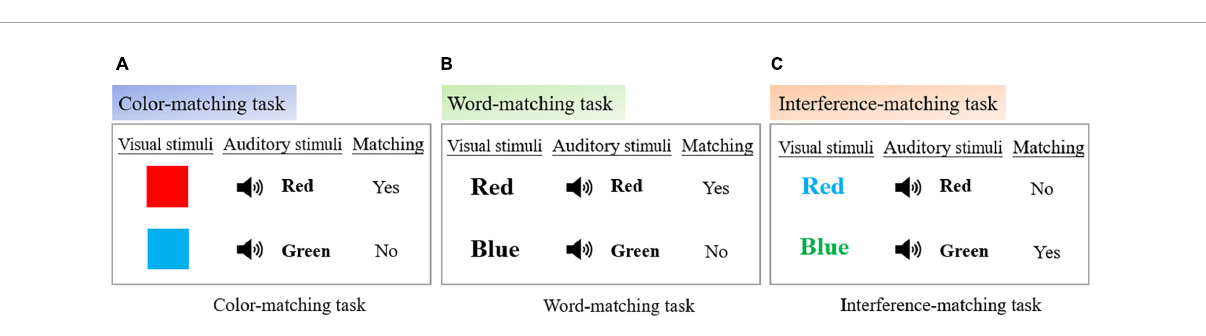
FIGURE3 Stroop task settings. (A) Color-matching task settings. (B) Word-matching task settings. (C) Interference-matching task